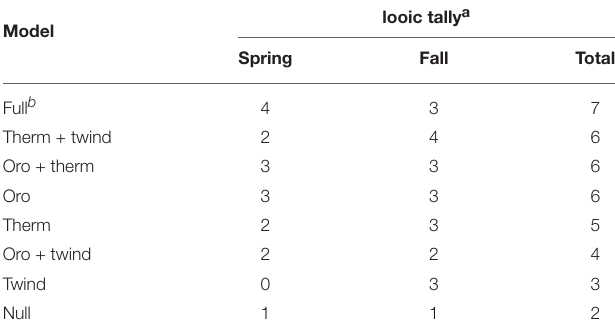
looic tally a Spring Fall